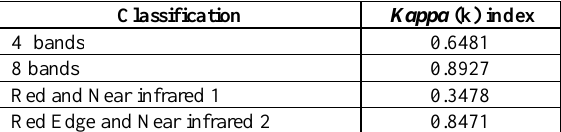
TABLE 1: Kappa indices of classifications.